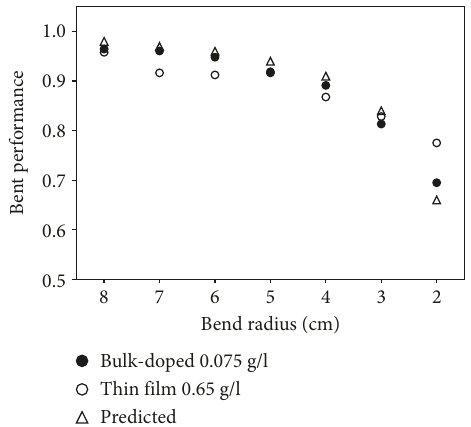
Figure 6: Absorbance spectra of bulk-doped, thin- fi lm, and clear LSC waveguides. The thin- fi lm waveguide had a 56% lower absorbance than the bulk-doped waveguide at 565nm. Quenching and self-absorption may limit thin- fi lm device performance at higher dye concentrations, resulting in devices that are optimized with lower optical densities.